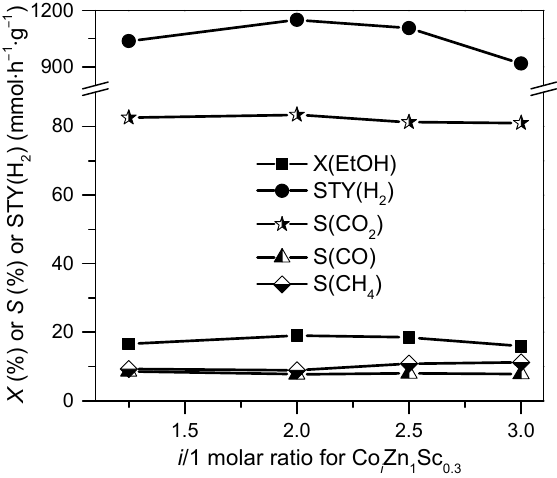
Figure 2. Performance of Co i Zn 1 Sc 0.3 catalyst for ESR to H 2 as a function of Co molar ratio. Reaction conditions: 0.5 MPa pressure, 723 K temperature, 15/45/40 molar ratio of EtOH/H 2 O/N 2 , and 150,000 mL·h − 1 ·g -cat − 1 GHSV.